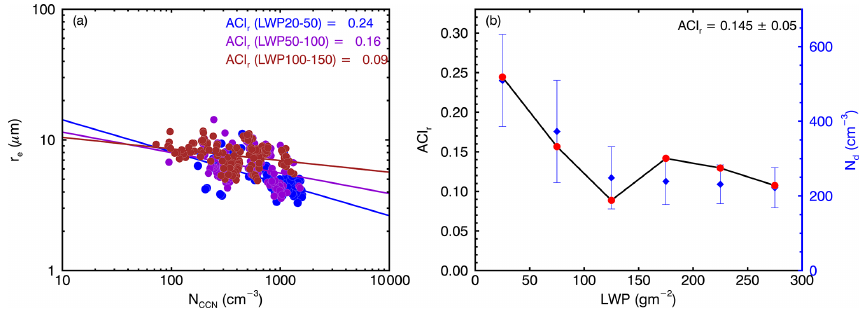
Figure 3. ACI r derived from (a) r e to N CCN in three LWP bins: 20–50gm − 2 (blue), 50–100gm − 2 (purple), and 100–150gm − 2 (dark red). (b) Relationship of ACI r (red dot, left ordinate) and N d (blue diamond, right ordinate) to binned LWP. Blue whiskers denote 1 standard deviation for each